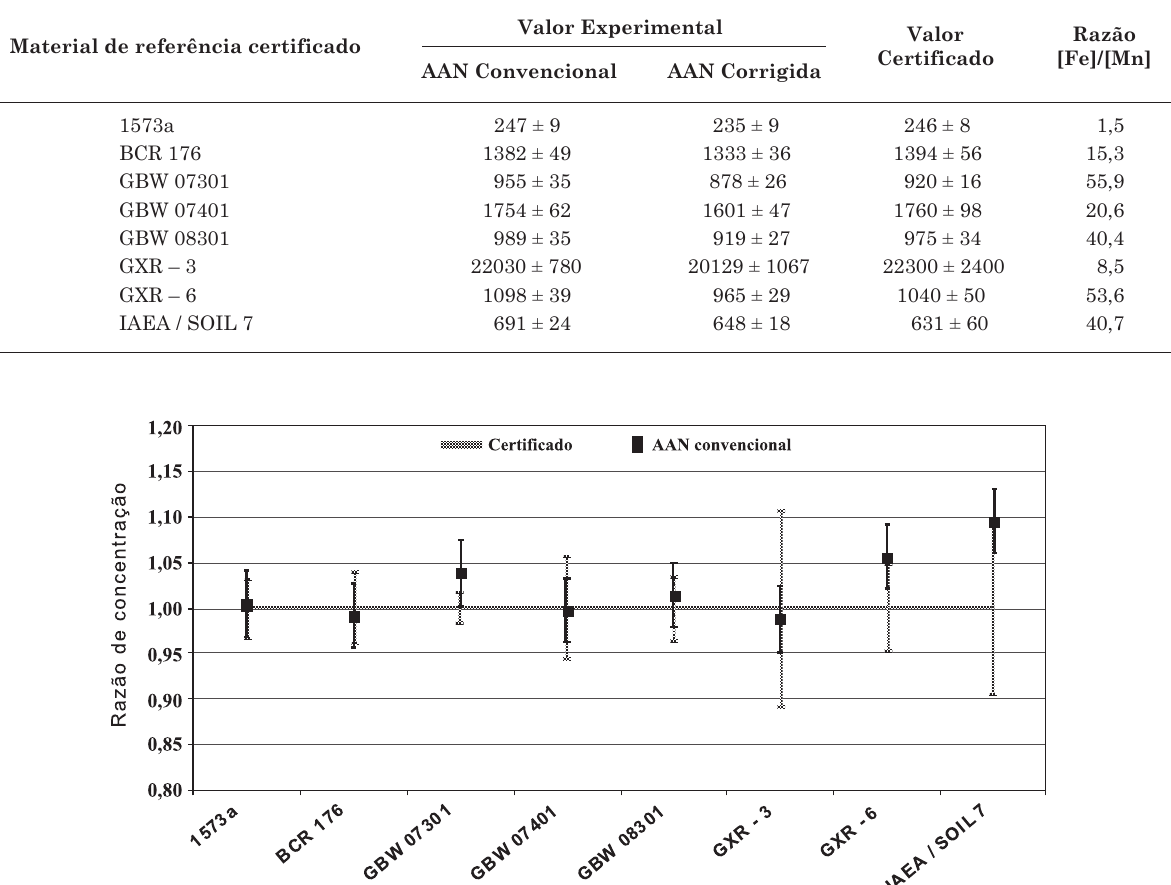
Figura 2. mn: comparação entre os valores experimentais convencionais e os valores certificados. as barras verticais são as incertezas